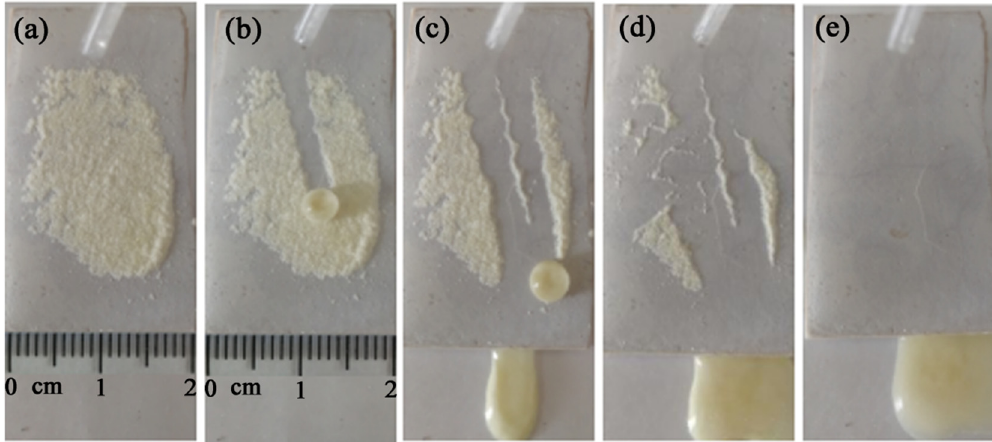
Figure 8. ( a – e ) Self-cleaning process of the superhydrophobic glass-ceramic surface.